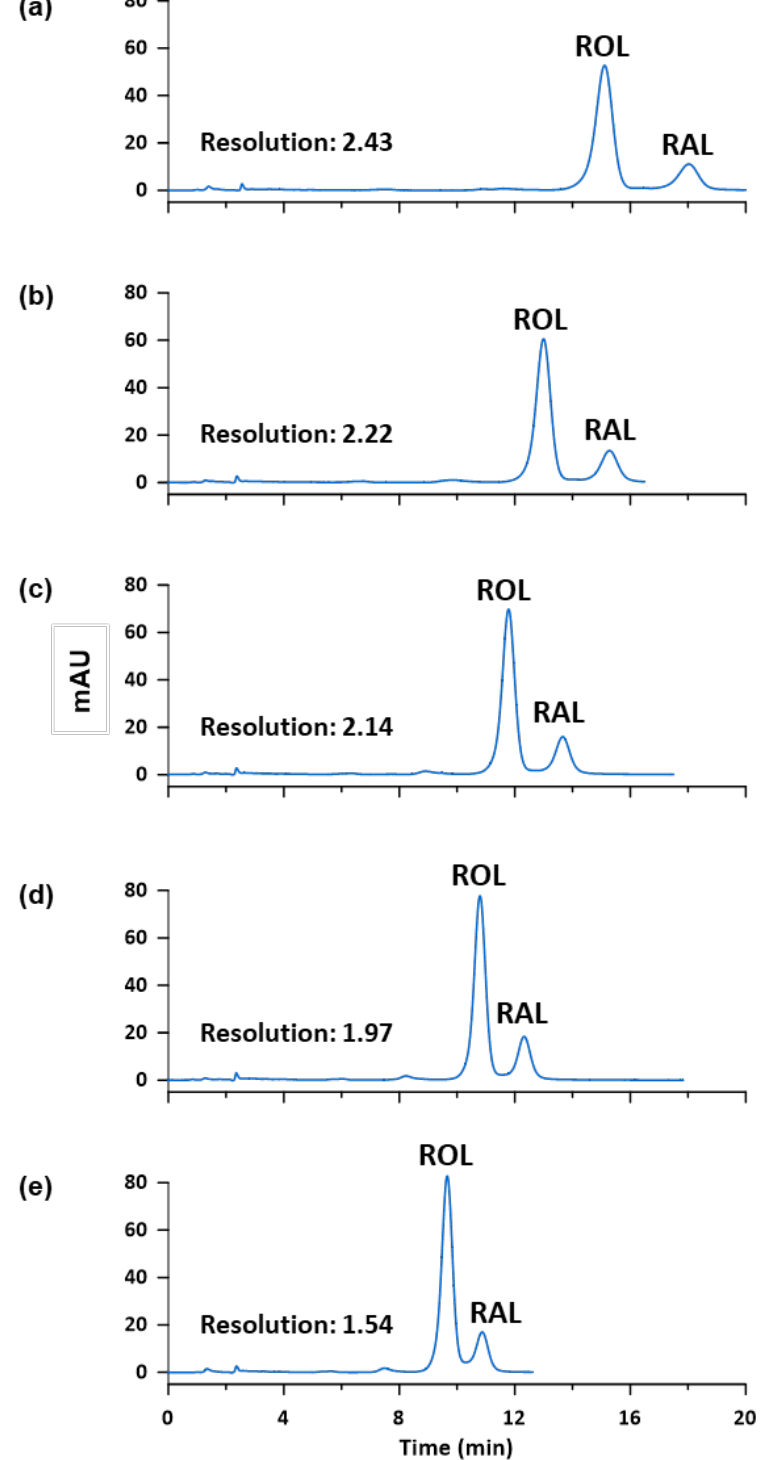
Figure 3. Chromatograms of a standard solution containing ROL and RAL at 10 µg mL −1 obtained at ( a ) 25 °C, ( b ) 30 °C, ( c ) 35 °C, ( d ) 40 °C and ( e ) 45 °C.